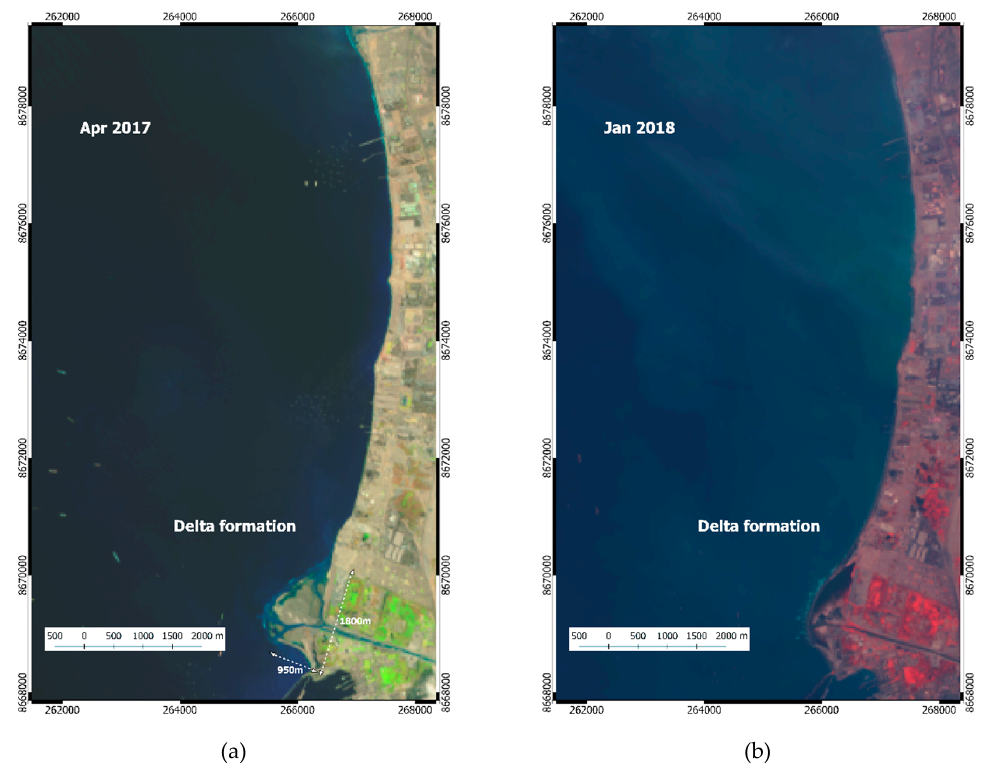
Figure 7. Rimac Delta formation in 2017, ( a ) Delta just after the EN occurs, ( b ) Delta 9 months later.